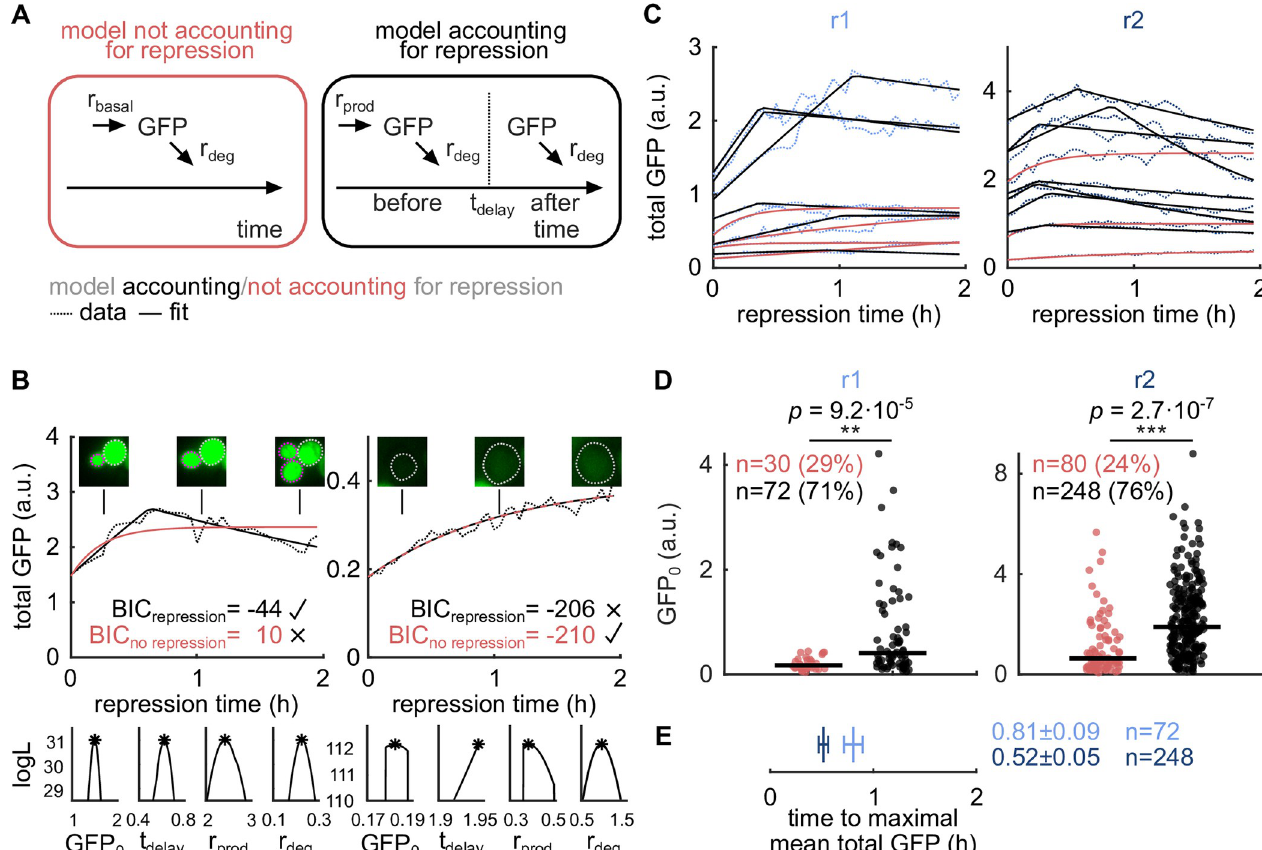
Fig 3. Fraction of cells with repression kinetics cannot explain the faster response upon repeated repression. (A) Left: a model for cells without repression kinetics composed of basal GFP production (r basal ) and degradation (r deg ). Right: a model for cells with repression kinetics composed of an initial constant and active GFP production (r prod ) and degradation (r deg ) until a delayed repression onset (t delay ) where GFP production is switched off. (B) Top: two exemplary total GFP traces (dotted line) and fits of the model not accounting for repression (red solid line) and model accounting for repression (black solid line). Exemplary images of the cell(s) at three different time points are shown above. Mother cells are circled in gray, progeny in pink. The better fitting model was selected according to the Bayesian information criterion (BIC). Left: total GFP trace better fitted by the model accounting for repression. Right: total GFP trace fitted equally well by both models. Due to the higher model complexity of the model accounting for repression, the model accounting for repression is rejected. Bottom: profile likelihoods of the model accounting for repression corresponding to the two exemplary total GFP traces above endorse parameter identifiability. Asterisks represent optimized parameters and corresponding log-likelihood (logL) values. (C) Ten exemplary total GFP traces (dotted lines) and best fits (solid lines) for repressions r1 (left) and r2 (right). GFP traces best fitted with the model accounting for repression are shown in black and fits of total GFP traces best fitted with the model not accounting for repression are shown in red. (D) The median initial total GFP, GFP 0 , is significantly higher ( p = 9.2 � 10 − 5 and p = 2.7 � 10 − 7 , two-sided median test corrected for multiple testing with Bonferroni correction, m = 12) in traces better fitted by the model accounting for repression (black) than in traces better fitted by the model not accounting for repression (red). This confirms that the model accounting for repression fits induced cells better, while the model not accounting for repression fits uninduced cells. The number of cells and percentages of all GFP traces best fitted by the model accounting and not accounting for repression are shown. (E) Time to maximal mean total GFP is decreased in repression r2 for cells with repression kinetics (0.81 h ± 0.09 h vs. 0.52 h ± 0.05 h). Bootstrap (10 5 ) samples of the cells with repression kinetics were drawn to generate mean ± std.